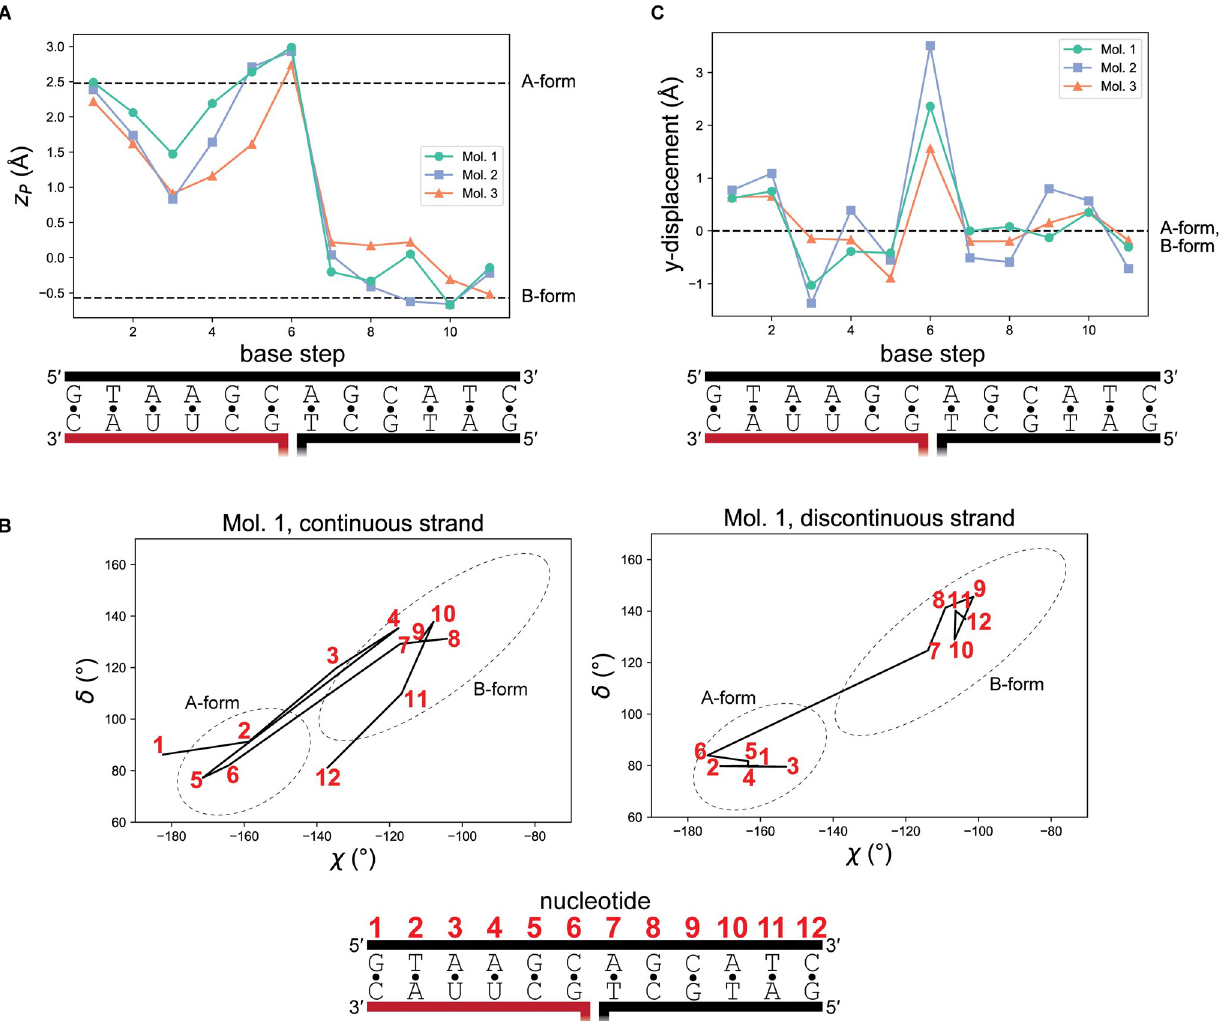
Fig 4. Geometric details of the A-to-B transition. (A) For a given base step, the parameter z is the mean of the z -displacement of the two phosphorus P atoms from the dimer’s reference xy -plane. Note that z P is defined by a pair of dinucleotides, so there are only 11 data points for a 12-bp helix, and integral x-values lie between the base pairs in the diagram. This parameter was originally introduced for its utility in distinguishing A-form from B-form base steps. Black, DNA; red, RNA. (B) χ and δ are the two nucleotide torsion angles that best distinguish A-form from B-form geometry. Note that these torsion angles are defined for each individual nucleotide, so there are 24 data points for a 12-bp helix. Integers in red refer to individual nucleotides, as indicated in the schematic at the bottom. Dashed ellipses were drawn to match those depicted in [27]. (C) Y-displacement. Similar to z P , this parameter describes base steps (pairs of dinucleotides), not individual nucleotides. This parameter cannot distinguish A-form from B-form geometry. Instead, note that the base step across the exchange point dramatically departs from both A-form and B-form